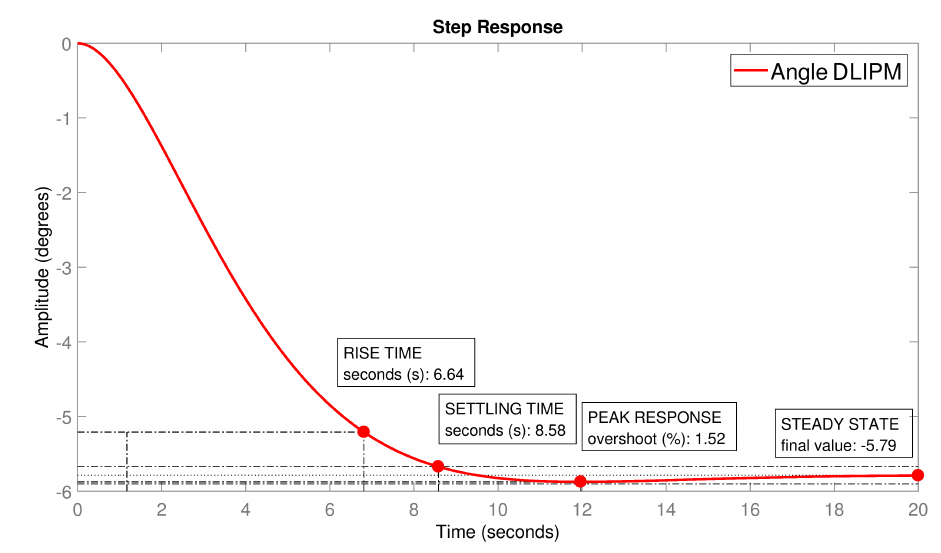
Figure 18. Angular step response of the